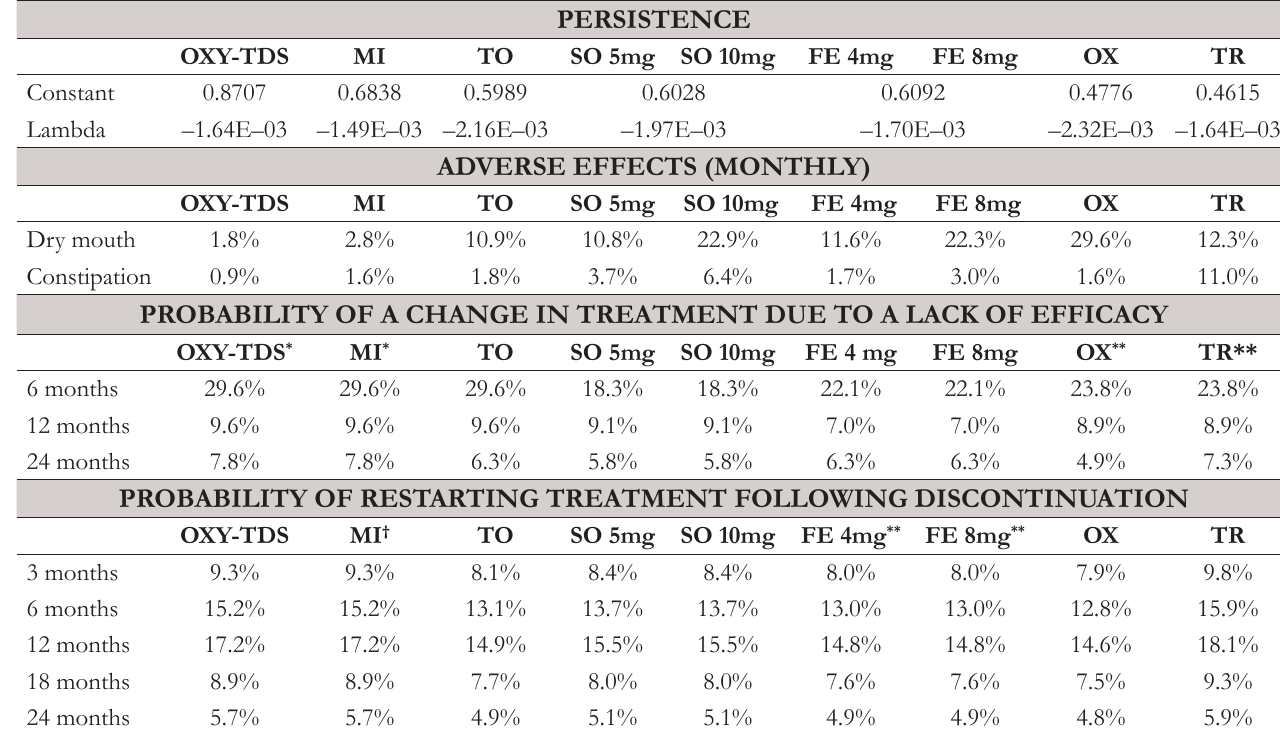
Table 1. Parameters for the